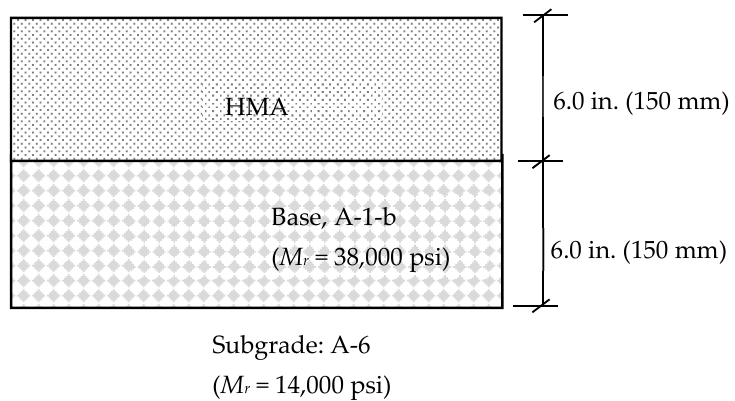
Figure 1. Geometry of the trial pavement for the AASHTOWare analysis of all groups.